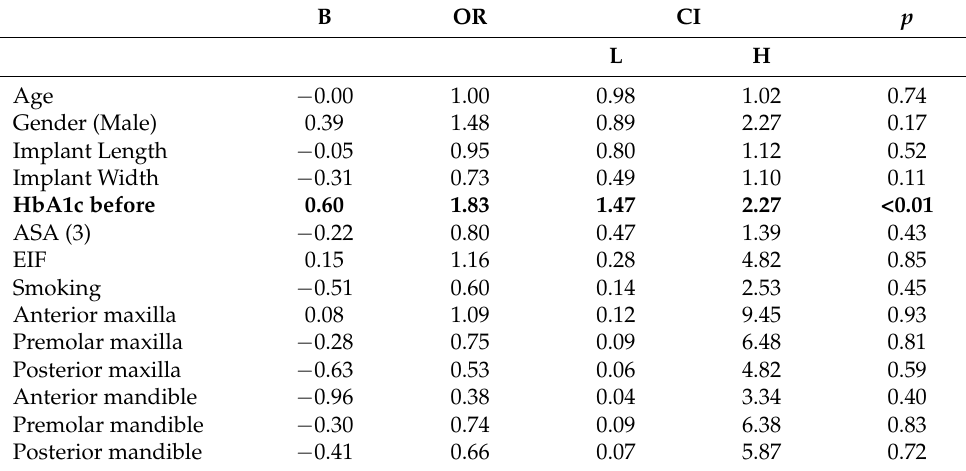
Table 6. Multivariate analysis (implant